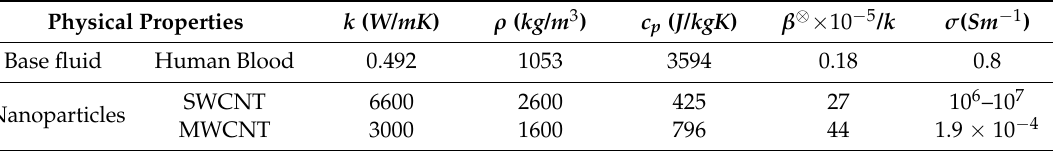
Table 1. Various mathematical values of thermophysical characteristics of CNTs of three base liquids [16].